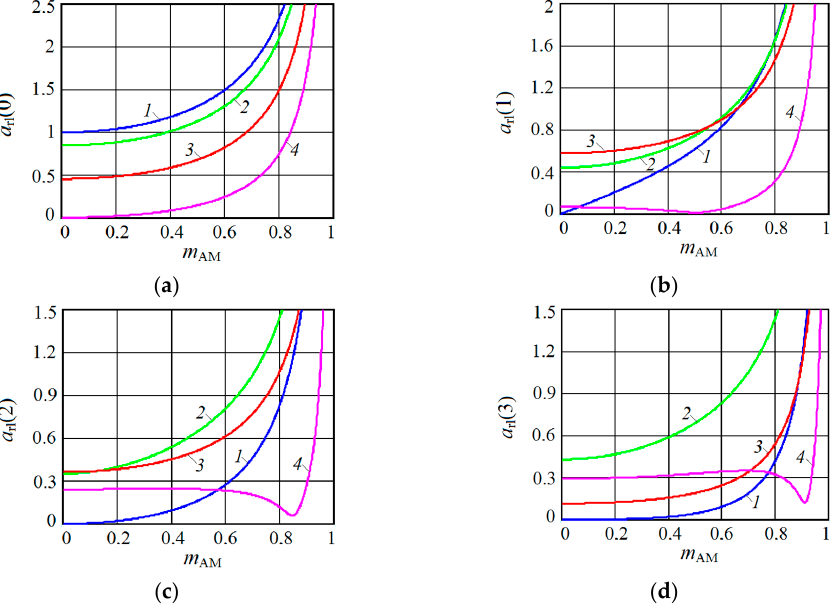
m Figure 6. Plots of CAS sections along axis Figure 6. Plots of CAS sections along axis m AM on ( a ) zero a rl ( 0 ) , ( b ) first a rl ( 1 ) , ( c ) second a rl ( 2 ) and AM and ( d ) third rl (3) a ( d ) third a rl ( 3 ) harmonics of the modulation frequency calculated at r nd = 0.5 for di ff erent values k FM . On plot a : k FM = 0 (curve 1), k FM = 0.4 (curve 2), k FM = 0.8 (curve 3), k FM = 1.2 (curve 4). On plot b : k FM = 0 (curve 1), k FM = 0.5 (curve 2), k FM = 1 (curve 3), k FM = 2 (curve 4). On plot c : k FM = 0 (curve 1), k FM = 1 (curve 2), k FM = 2 (curve 3), k FM = 3 (curve 4). On plot d : k FM = 0 (curve 1), k FM = 2 (curve 2), k FM = 3 (curve 3), k FM = 4 (curve